Question: Provide a one-line summary of what is displayed.
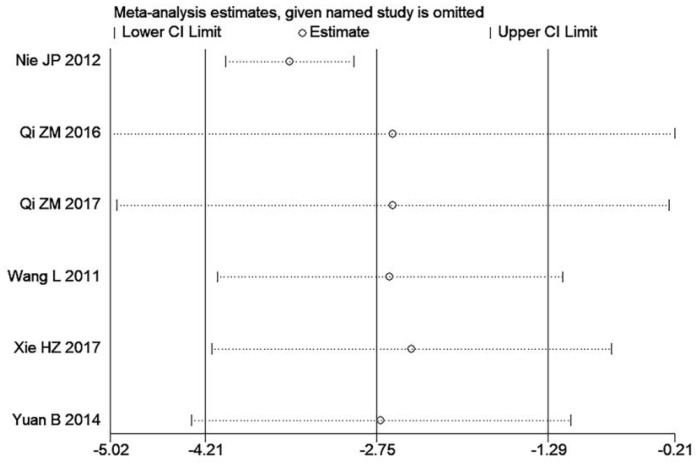
Answer: Results of the CRP sensitivity analysis in the CHM vs. WM group.